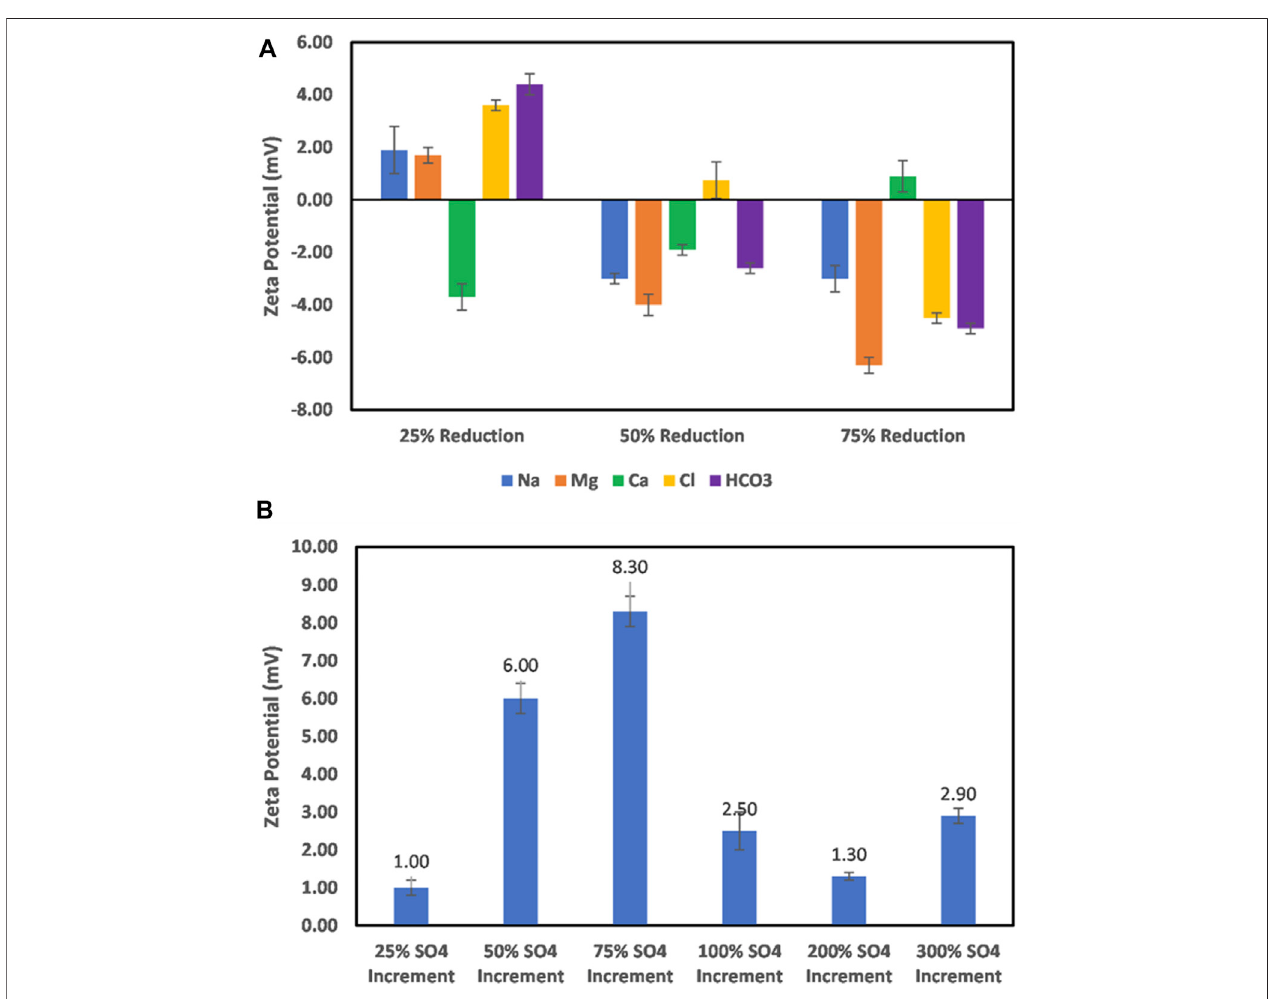
FIGURE 10 | (A) Effect of Na, Mg, and Ca, and HCO 3 ion concentration reduction on feldspar mineral surface charge. (B) Effect of increase in the sulfate ion concentration on feldspar mineral surface charge.